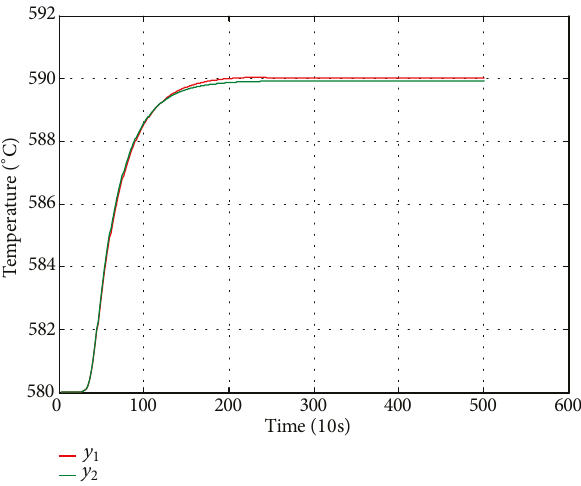
values of 𝑢 3 , 𝑢 4 are 0.03 and 0, respectively, which have